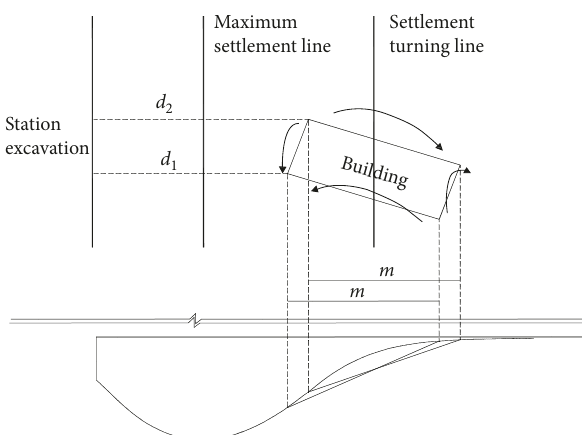
Figure 10: Torsional deformation of a building across the settle- ment turning line.